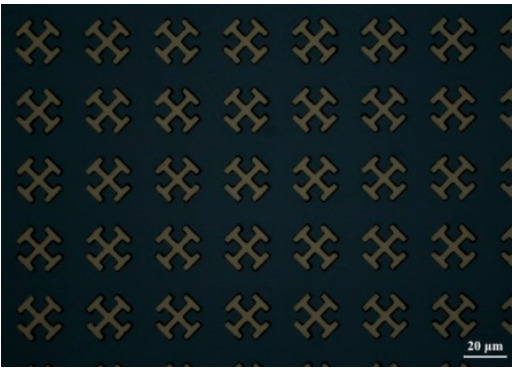
Figure 2. Optical microscopy of the “X” shaped metamaterial structure.